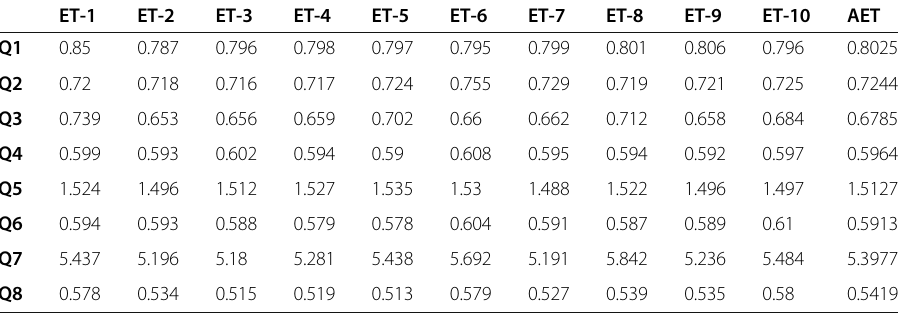
Table 10 Query execution time for RDS with Colorado State data for HC-2